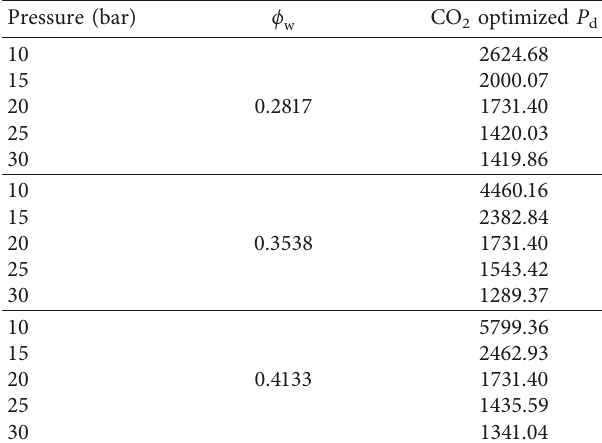
Table 6: Optimized P d for CO 2 .